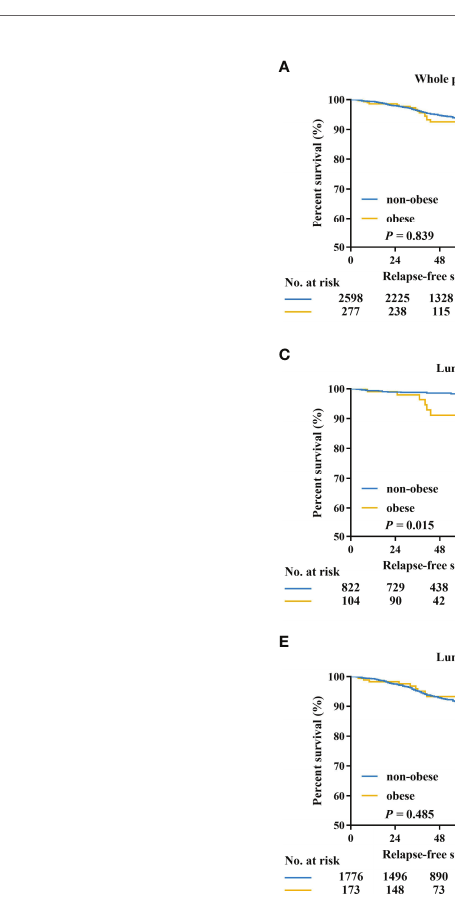
FIGURE 2 | Kaplan – Meier estimates of relapse-free survival and overall survival in patients with HR-positive/HER2-negative tumors (A, B) , luminal A tumors (C, D) , and luminal B tumors (E, F) . HR, hormone receptor; HER2, human epidermal growth factor receptor